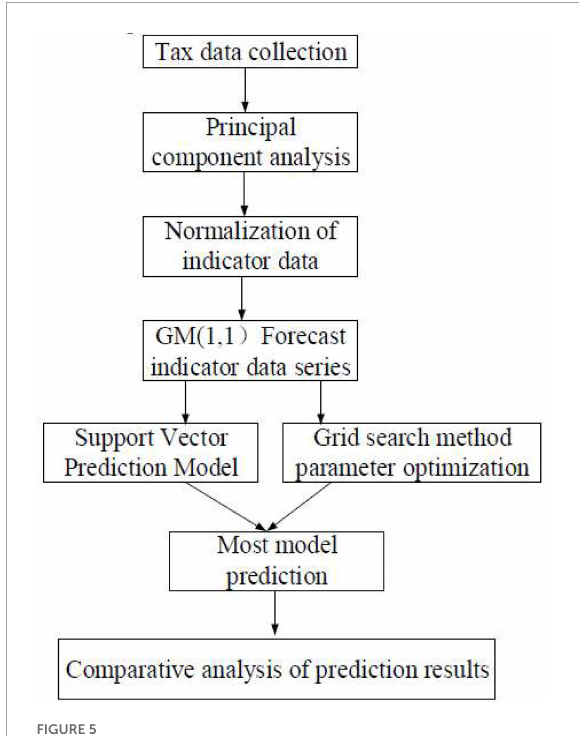
FIGURE5 Construction of the taxation fusion model based on support vector machine (SVM) for the ceramic industry in Jingdezhen.